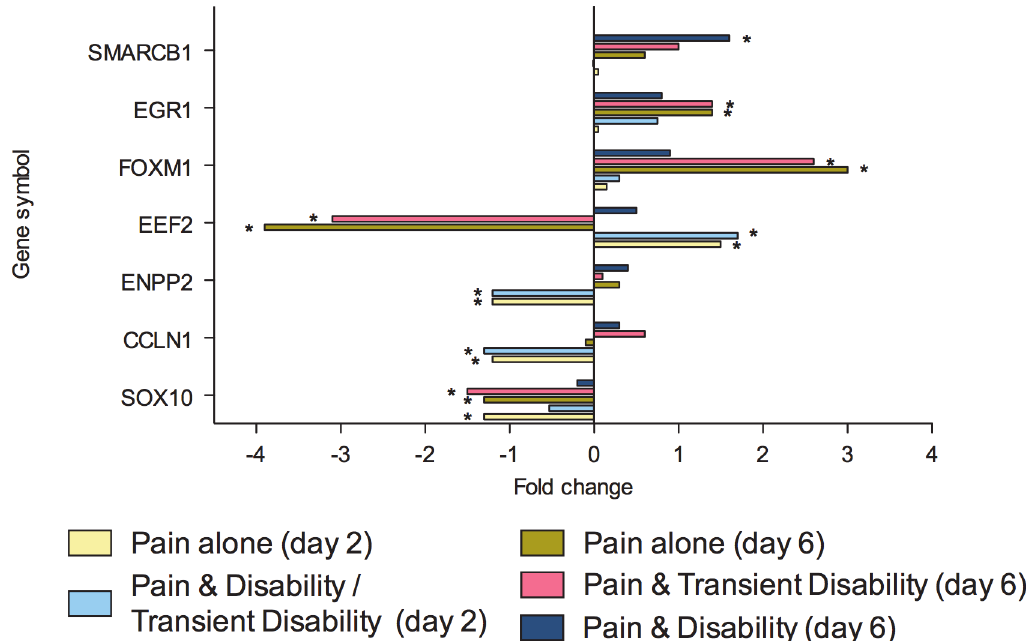
Fig 7. Gene transcripts, which encode for proteins involved in transcriptional or translational processes, that are specifically regulated in the lumbar spinal cord after CCI, as determined by microarray analysis. Changes in gene expression have been tested at both 2 and 6 days after CCI on pooled mRNA samples from each disability group, compared to uninjured controls. * Indicates up- or down-regulation determined by MAS v5.0.